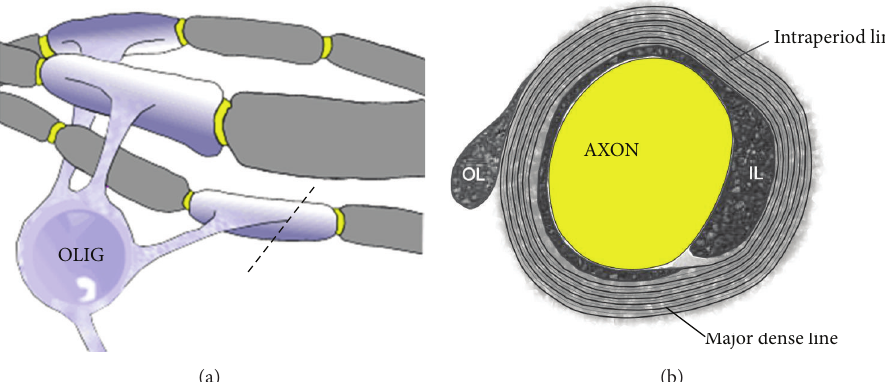
Figure 1: Stylized diagram of myelinated nerve fibres in the CNS. (a) Myelin is produced by the oligodendrocyte (OLIG) and is laid down in segments along nerve axons. Single oligodendrocytes can myelinate up to 50 segments. The area of bare axon between each myelinated segment (shown in yellow) is called the node of Ranvier. Electrical impulses move down the axon by “jumping” from one node to another in a process known as saltatory conduction. A cross-section through the myelinated segment at the dotted line is shown in (b). (b) The myelin sheath forms from flattened cytoplasmic processes from the oligodendrocyte that are elaborated around the axon and which then compact their cytoplasmic content (except for small pockets at the periphery of the membrane, which can appear as the inner loop (IL) immediately adjacent to the axon and the outer loop (OL) at the outer edge of the membrane). The major dense line represents the compacted cytoplasm. The intraperiod line is formed by close apposition of the membrane layers.